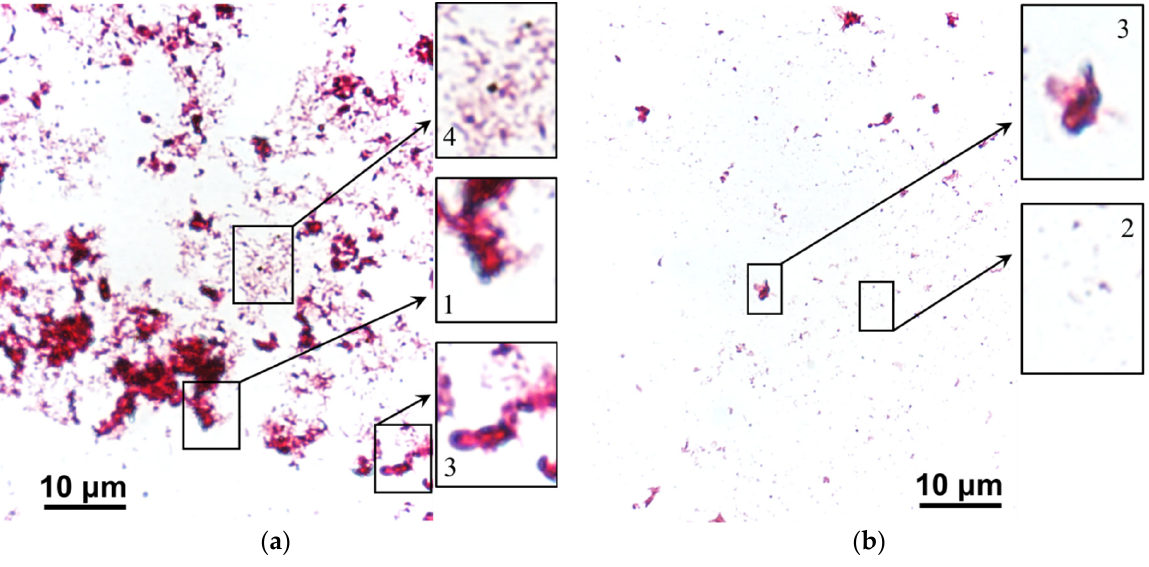
( c ) Figure 13. Photo of the cleaning solution ( a ) as well as the surfaces of the CJMA-6 anion-exchange membrane after cleaning in operando with ( b ) and without an electric field ( c ). Apparently, in the case of CJMA-6, a change in the direction of the electric current during cleaning led to the transport of Cl – anions from the adjacent compartment. A sig- nificant increase in Cl – concentration at the foulant layer/solution interface caused the de- struction of hydrogen bonds between the components of colloidal particles due to the well-known effect of “salting out” [74]. The gravitational force compelled the formed con- glomerates of colloidal particles to move down, and the forced convection of the solution